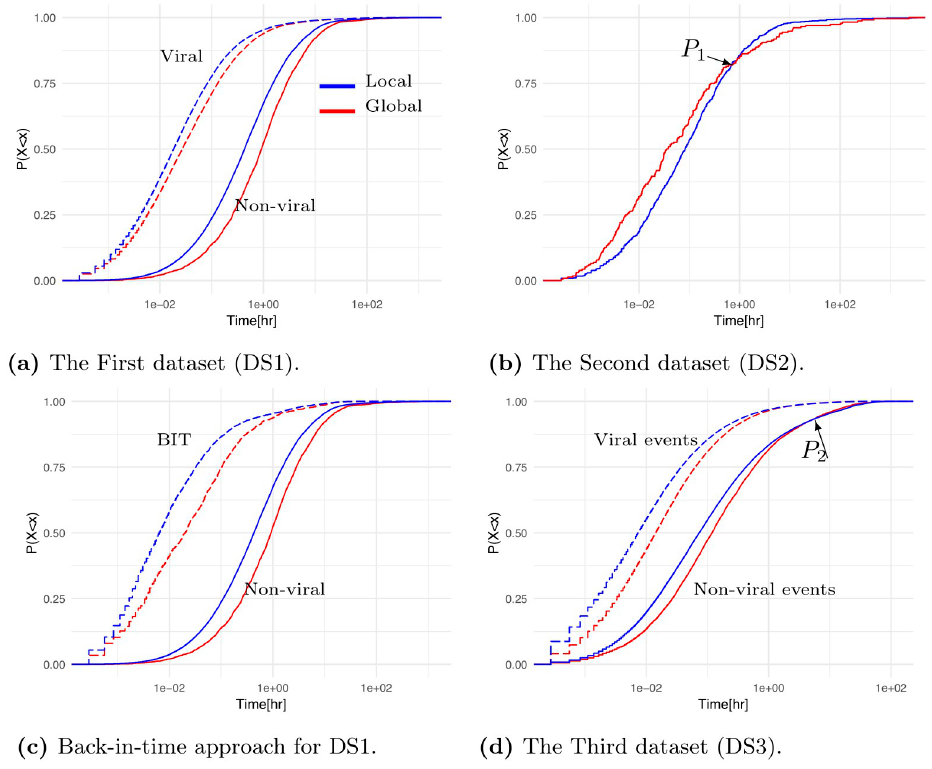
Fig 4. ECDFs of inter-retweet times. The time axis scale is transformed into a log scale.